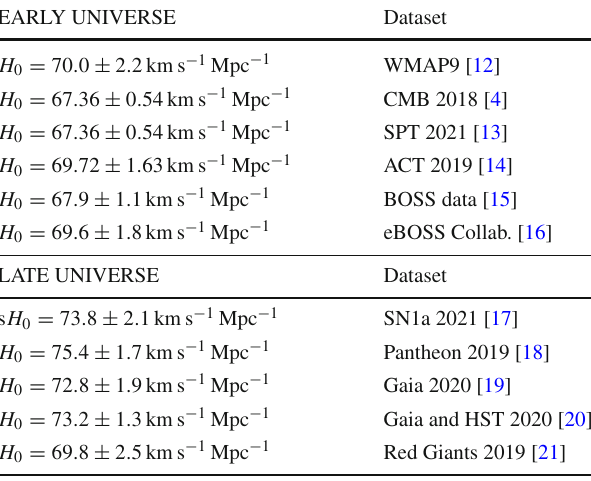
Table 1 Early and late universe evaluations of the Hubble constant and their respective data sets EARLY